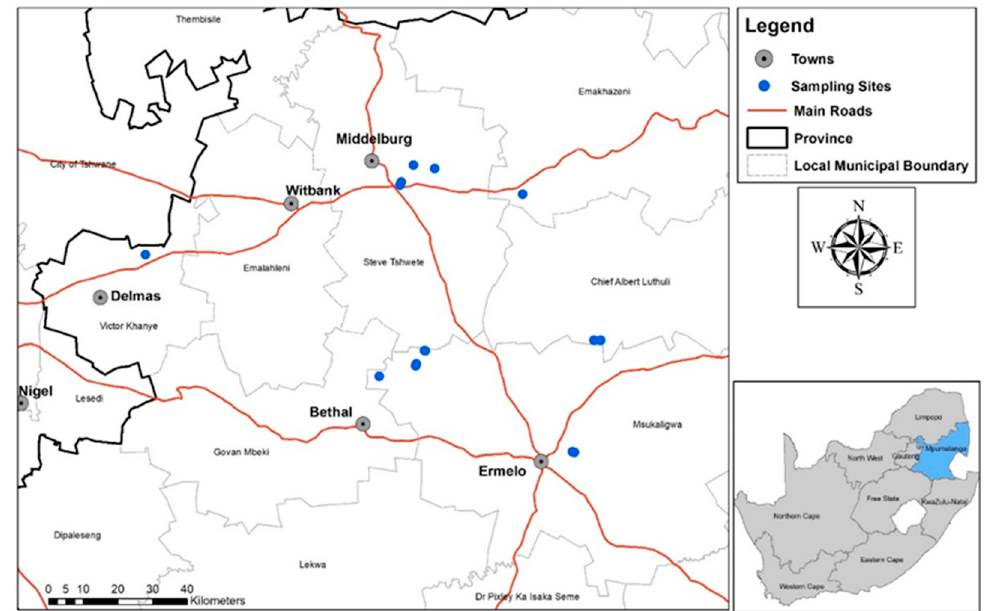
Figure 1. Soybean localities, situated in the Mpumalanga province of South Africa, where rhizosphere samples were obtained for nematode and microbe analyses during flowering of the crops in the 2019 summer growing season. (Illustration: Wiltrud Durand, BFAP, GIS & Crop Modelling).